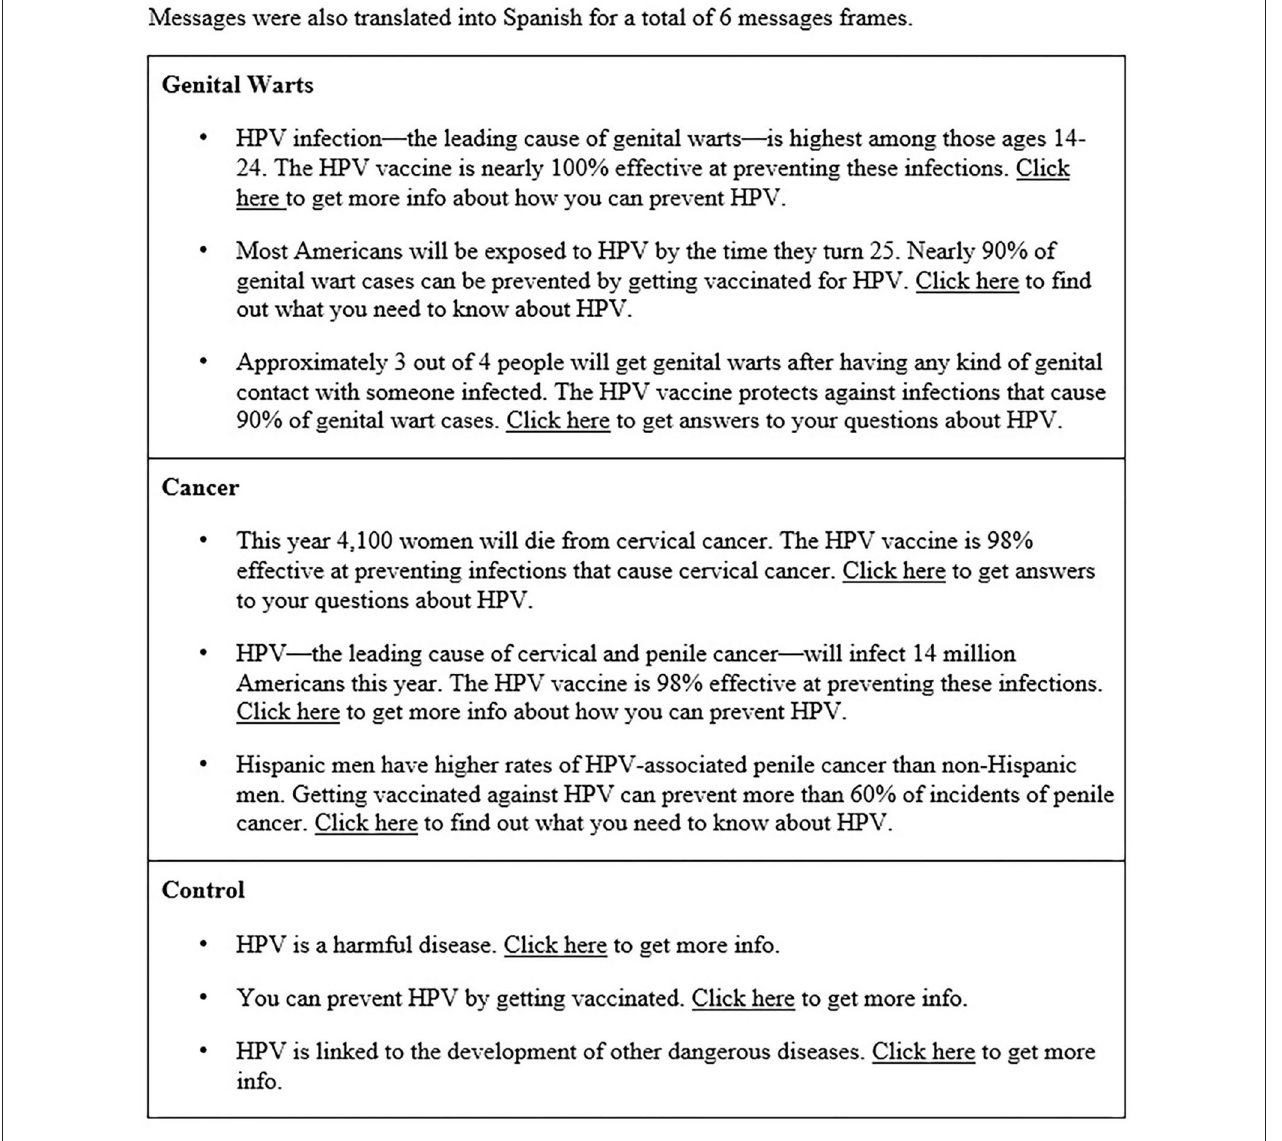
FIGURE 1 | Message